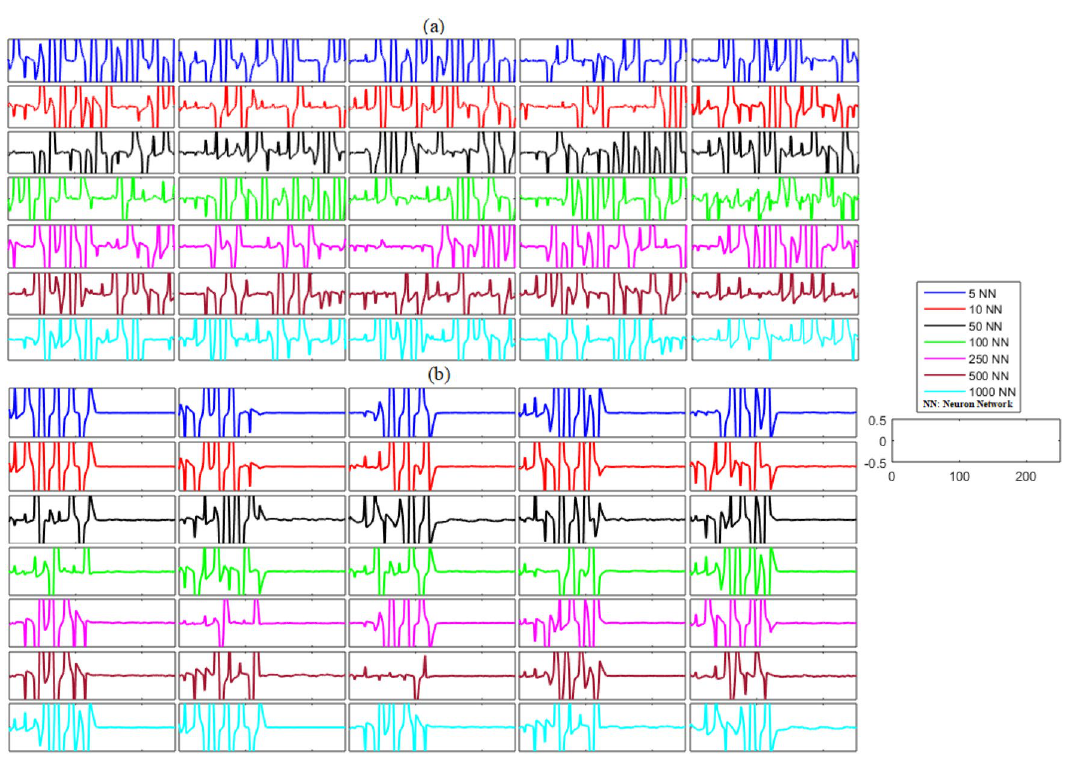
Figure 7. ( a ) Without control synchronization dynamics of the recovery variable states (y-states) of different time-delayed bidirectional FHN networks without noise. ( b ) Controlled synchronized error dynamics of the recovery variable states (y-states) of different time-delayed bidirectional FHN neuronal networks without